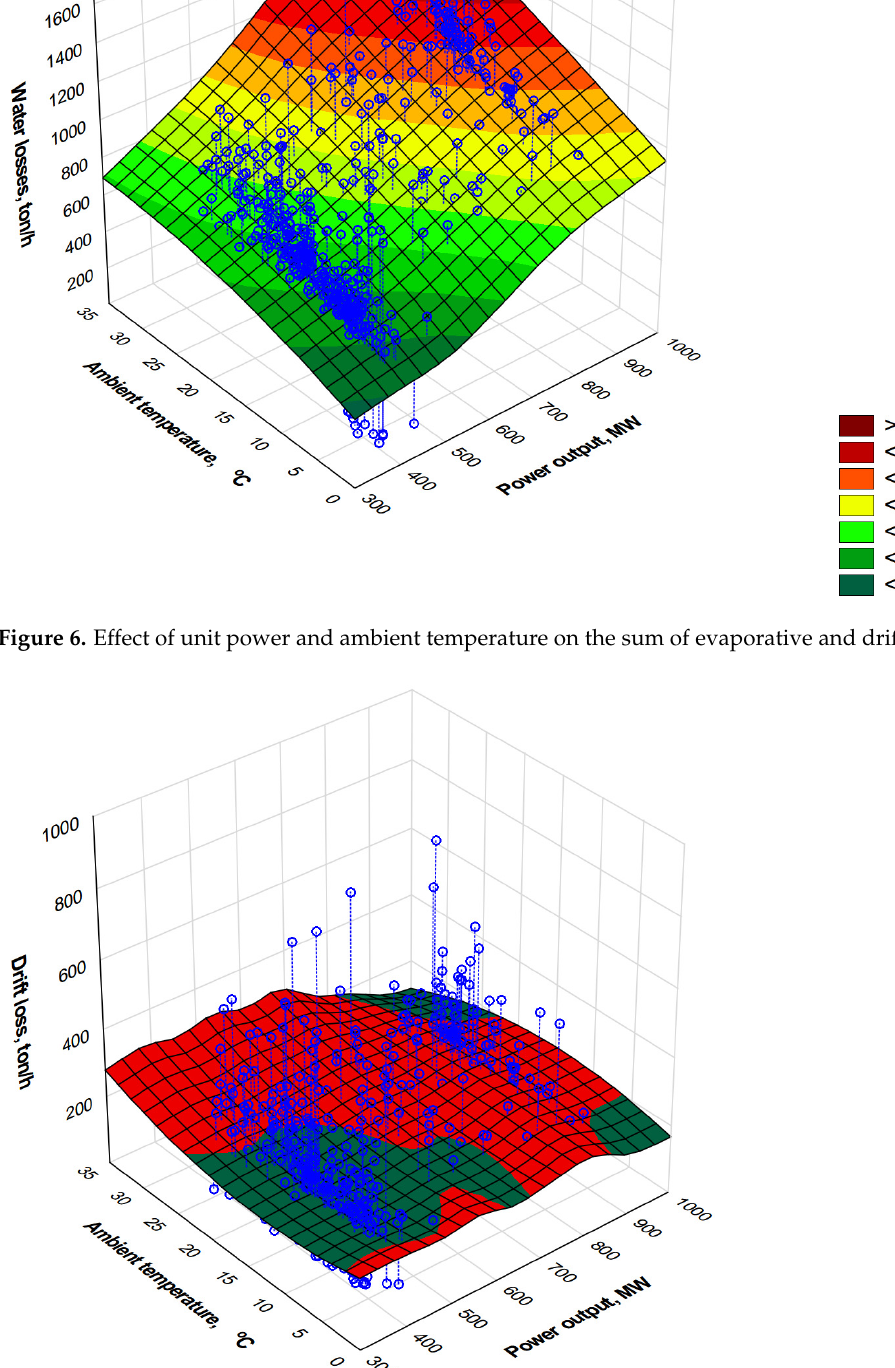
Figure 7. Drift loss as a function of the unit power output and ambient temperature ( ϕ = 70 ± 10%) .